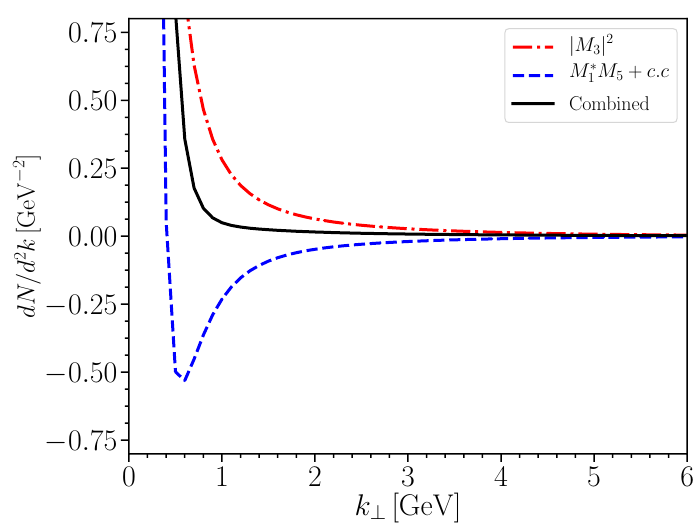
Figure 6. Comparing the | M 3 | 2 and M ∗